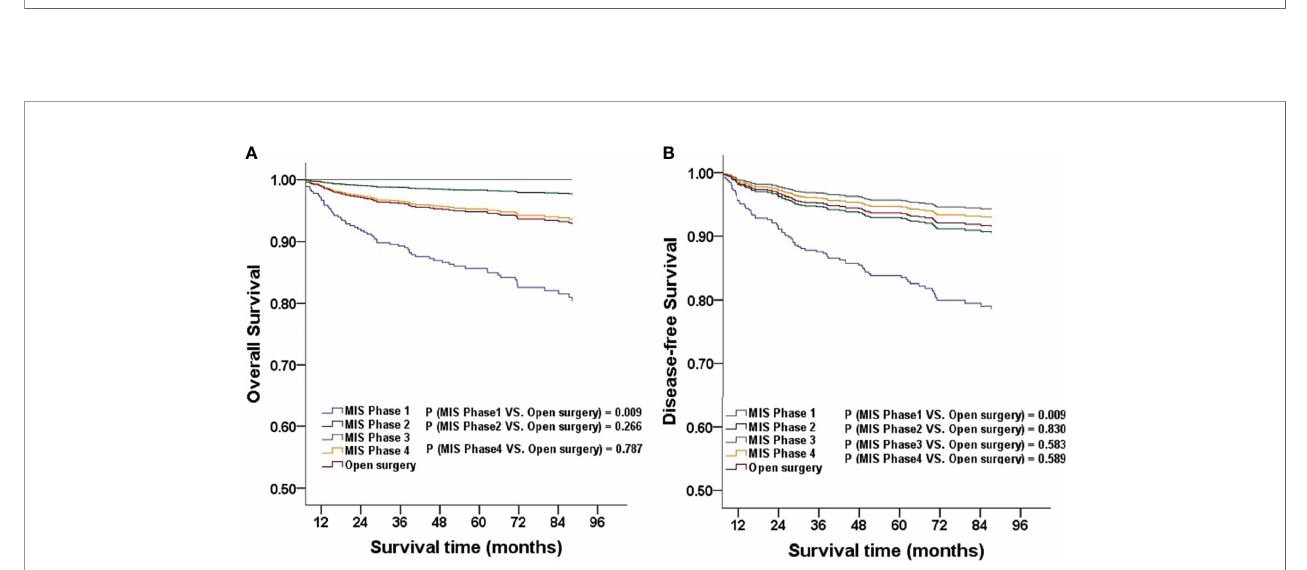
FIGURE 2 | The OS and DFS adjusted for clinicopathological factors for patients strati fi ed by phase (A, B) . MIS, minimally invasive surgery.